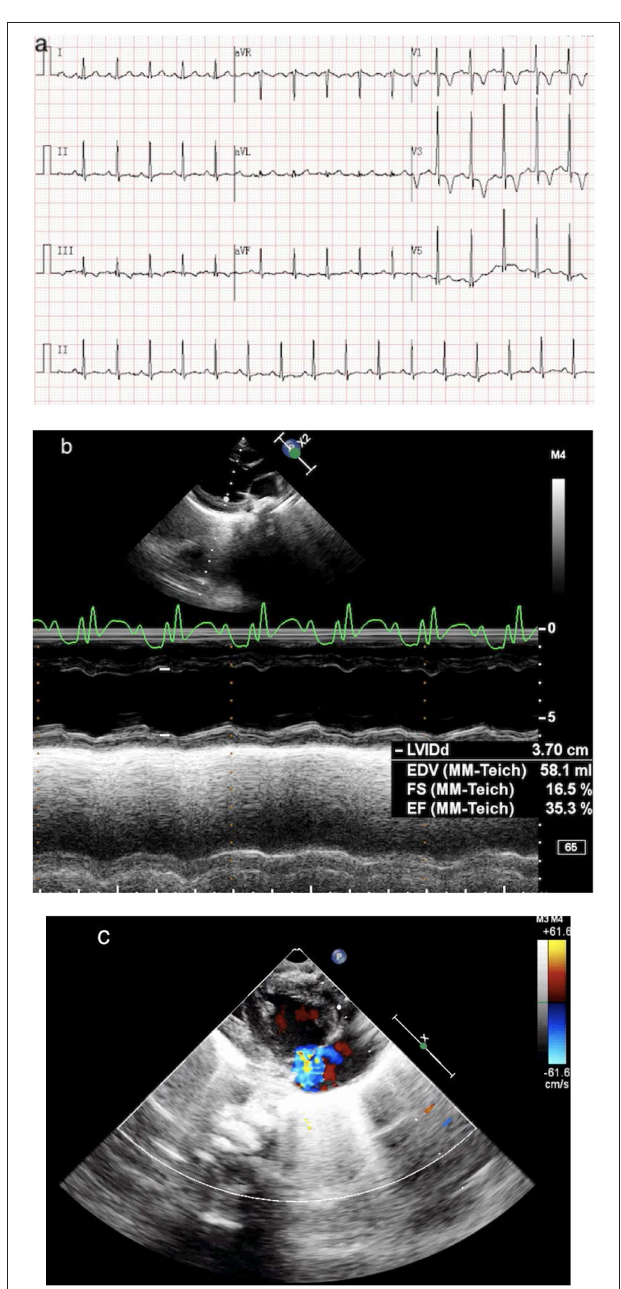
FIGURE 1 | (a) ECG shows sinus tachycardia with lowering and inverted T wave on leads II, III, and avF. (b) Echo shows a dilated, poorly functioning left ventricle (EF 35%). (c) Echo shows a severe